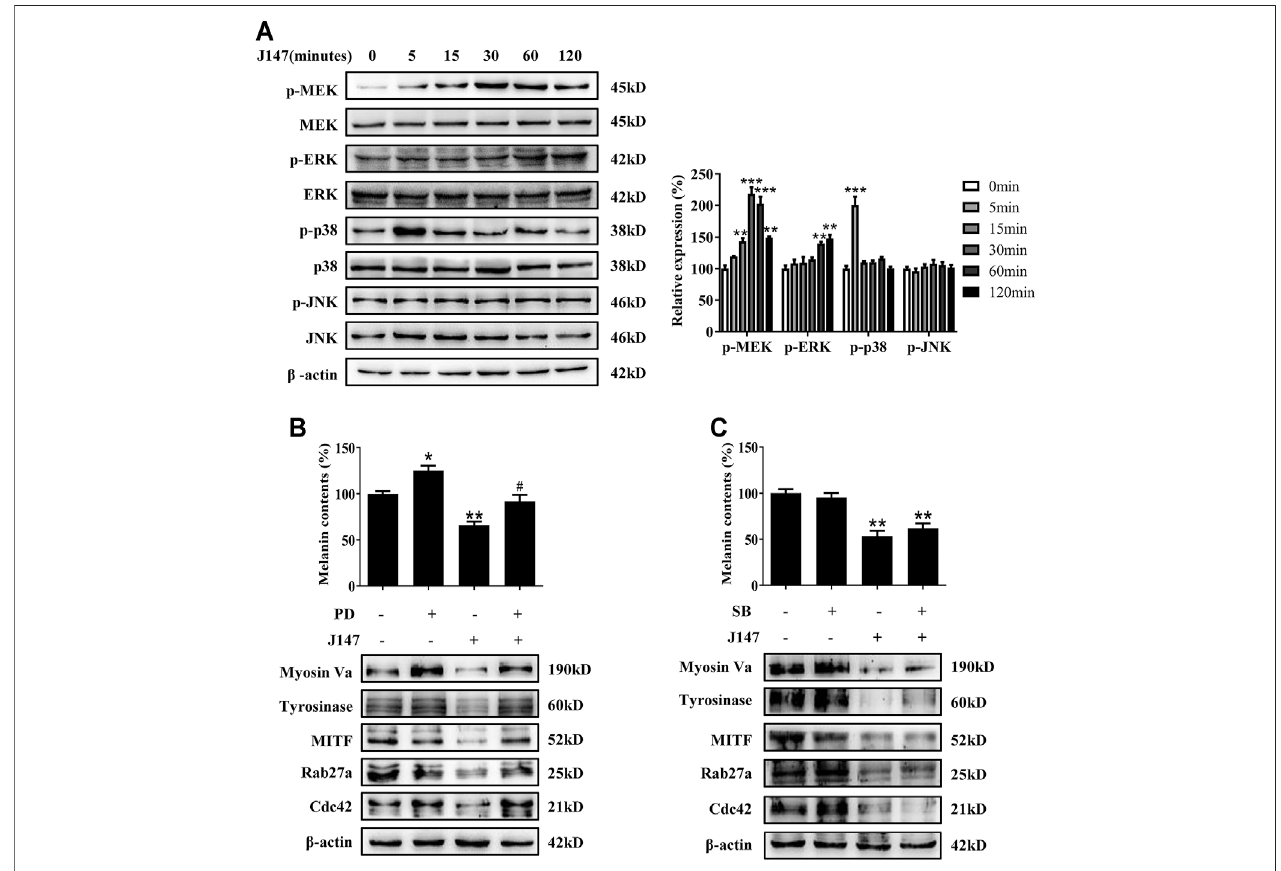
FIGURE 5 | Effect of MAPK pathway on J147-induced hypomelanogenesis. (A) B16F10 cells were treated with J147 (4 μ M) for the indicated time period (0 – 120 min), and the phosphorylation of the MEK, ERK, p38 and JNK were measured by western blot. (B) B16F10 was pretreated or not with 10 μ M SB203580 (the inhibitor of p38) for 1 h before J147 was applied for 48 h. Melanin contents and the expression of Myosin Va, tyrosinase, MITF, Cdc42 and Rab27a were measured as describedinmethods. (C) B16F10waspretreatedornotwith10 μ MPD98059(theinhibitorofERK)for1 hbeforeJ147wasappliedfor48 h.Melanincontentsand theexpressionofMyosinVa,tyrosinase,MITF,Cdc42andRab27aweremeasuredasdescribedinmethods.Dataareexpressedasthemean ± SE( n (cid:2) 3).* p < 0.05,** p < 0.01, *** p < 0.001 vs. non-treated cells. # p < 0.05 vs. J147-treated cells.